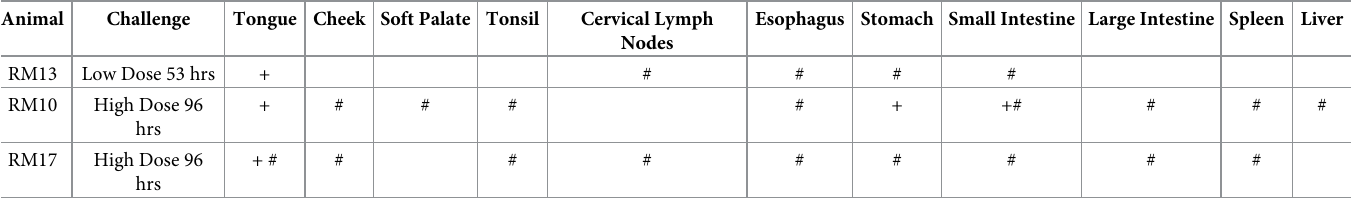
LICh viral vector mainly found in the tongue after oral challenge. SHIV-1157ipd3N4 viral dissemination found throughout the GI tract after oral challenge. + indicates mCherry DNA found; # indicates gag DNA